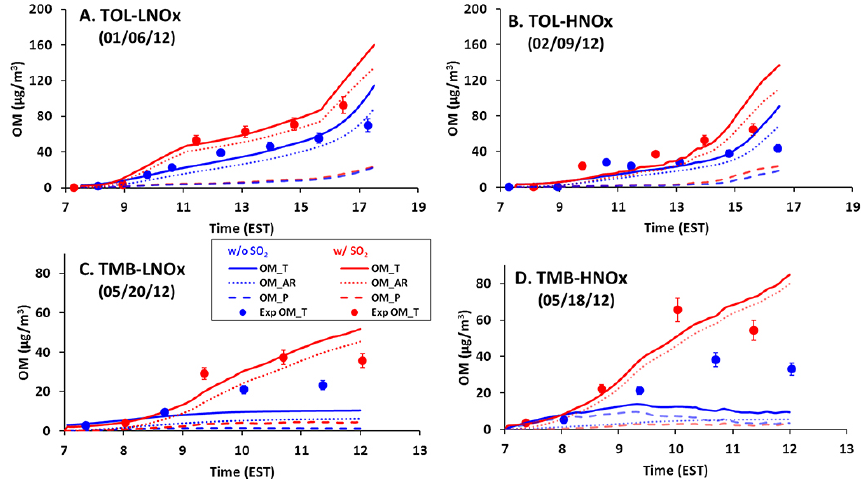
Fig. 3. Time profiles of measured (symbols) and simulated SOA mass concentrations for toluene SOA and 135-TMB SOA under low and high NO x conditions. The red and blue colors indicate experiments with and without SO 2 , respectively. Solid, dashed, and dotted lines represent total OM (OM T ), the OM from partitioning (OM P ), and the OM from the aerosol-phase reaction (OM AR ), respectively. The uncertainty associated with OM (about 9%) is estimated from the uncertainties of OC measurements and particle wall loss